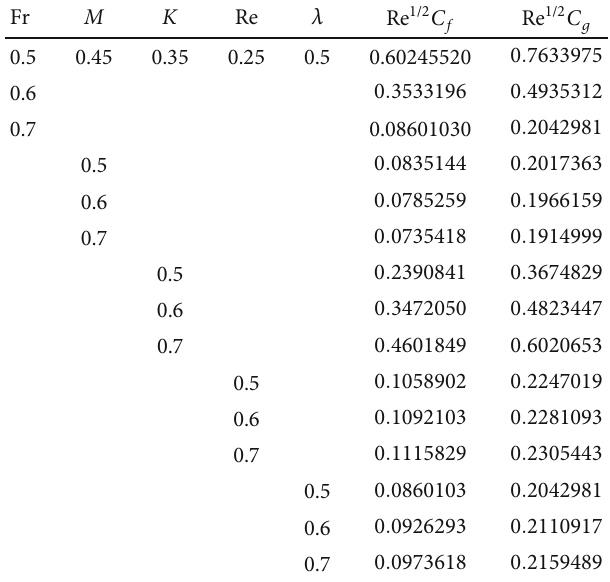
and Re 1/2 C when R = 0 : 3, θ f g